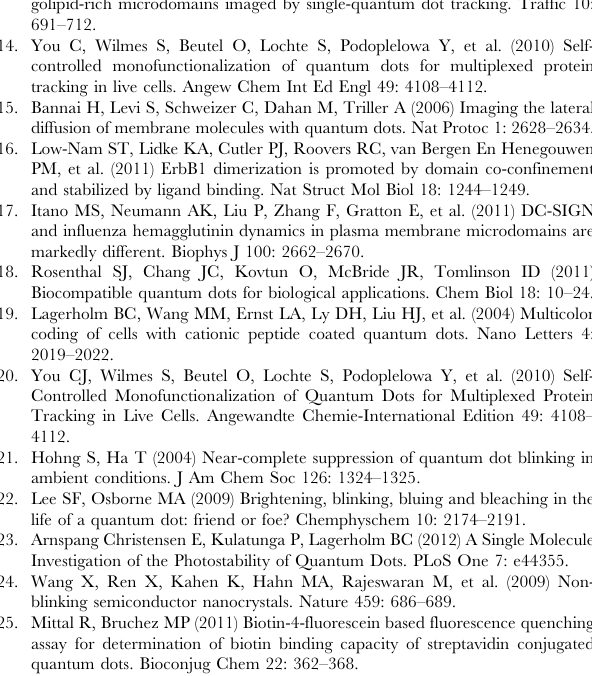
Table S5 Localization precision of single QD imaging. (DOC) Table S6 Summary of MC-SPT results for four color tracking of biotin-cap-DPPE labeled with each type of sAv-QD. (DOC) Table S7 p-values for non-parametric two-sided Kol- mogorov-Smirnov test of the diffusion coefficient of biotin-cap-DPPE in live MEFs. White shade= Statistical significant difference at confidence level of a # 0.05. Gray shade = No statistical significant difference at confidence level of a # 0.05. (DOC) Movie S1 QD fluorescence intensity. Representative video comparison of the fluorescence intensities of QD525, QD565, lapse images in each instance were acquired with 5 ms camera integration at an image acquisition rate of < 25 Hz using a Hg arc lamp, a 470/40 nm bandpass excitation filter, a 500 LP emission filter, a 150X, 1.45 NA objective, and an Andor EMCCD BV887. All images are displayed at identical brightness and contrast ratios and are hence directly comparable. Scale bar equals 10 m